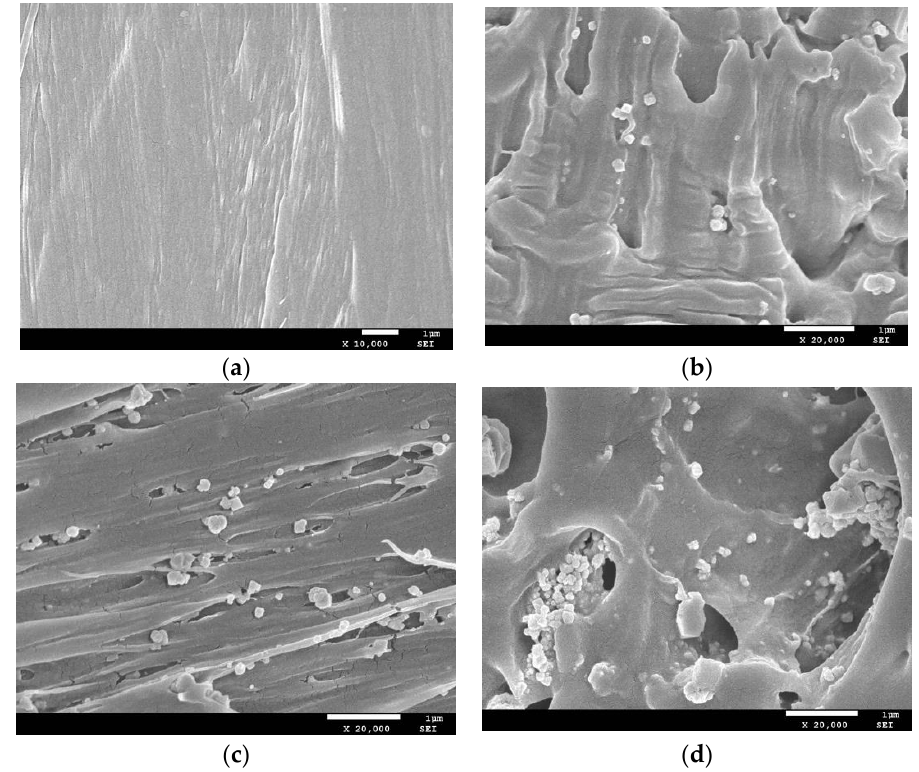
Figure 7. SEM cross-section of pure PLA and nano-Fe 3 O 4 / PLA composite absorbers. ( a ) Pure PLA absorber; ( b ) 10 wt% nano-Fe 3 O 4 / PLA composite absorber; ( c ) 20 wt% nano-Fe 3 O 4 / PLA composite absorber; and ( d ) 30 wt% nano-Fe 3 O 4 /PLA composite absorber.